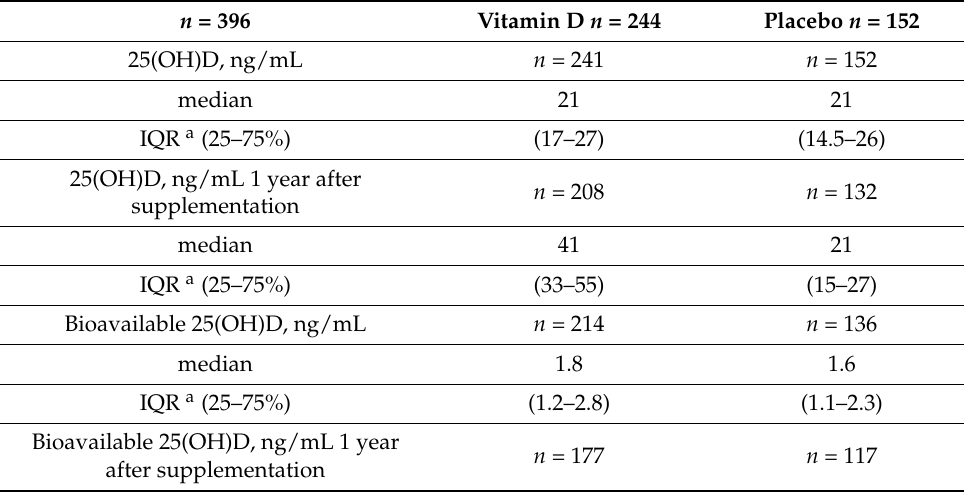
Table 1. Patients’ characteristics stratified by Vitamin D vs. Placebo .